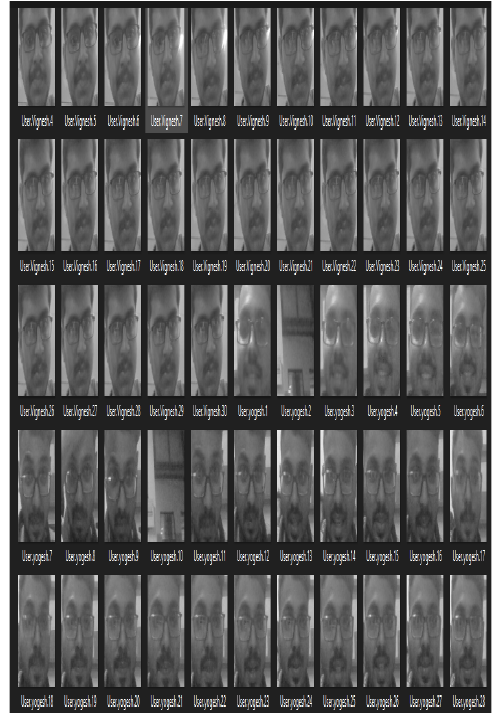
Figure 2. Images stored in the database.